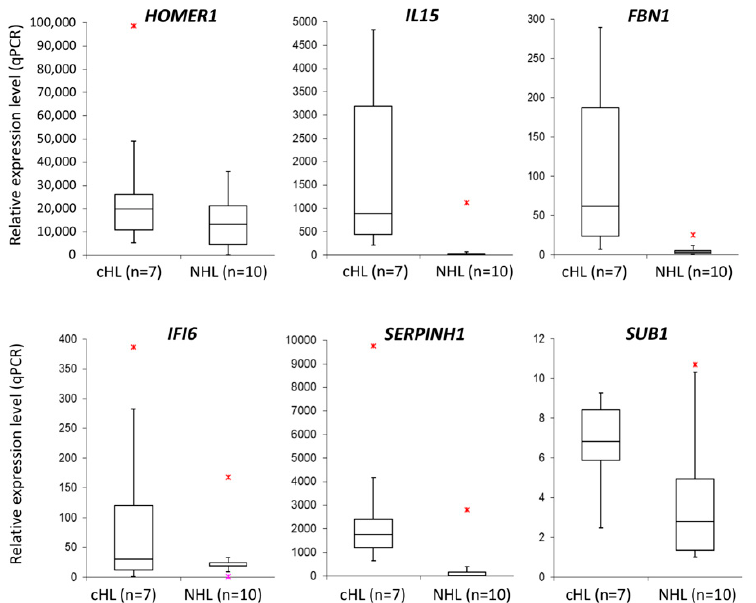
Figure 4. Overexpression of mir-148a putative target genes ( HOMER1, IL15, FBN1, IFI6, SERPINH1 and SUB1 ) in cHL cell lines ( n = 7) as compared to NHL cell lines ( n = 10) (real-time qPCR); - max. outlier.